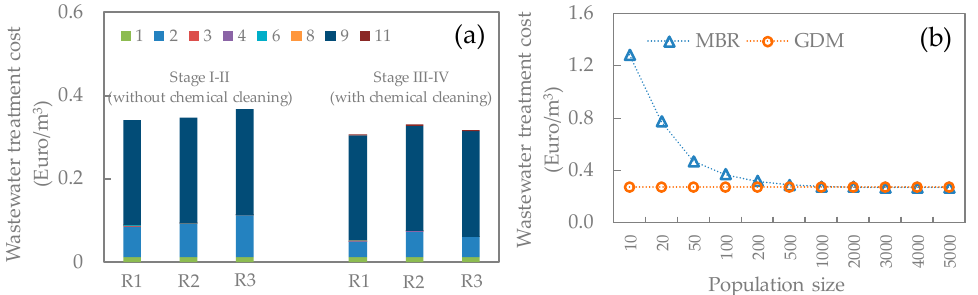
Figure 6. ( a ) Water production cost of GDM systems. The numbers shown in the legend represent the cost items shown in Table 2. Capital cost item: 1—reactor tank; 2—membrane; 3—feed pump; 4—air blower (for biological); 6—biocarriers. Operational cost item: 8—feed pump energy cost; 9—air blower (for biological) energy cost; 11—chemical cost. ( b ) Comparison of water production cost in GDM and MBR systems.